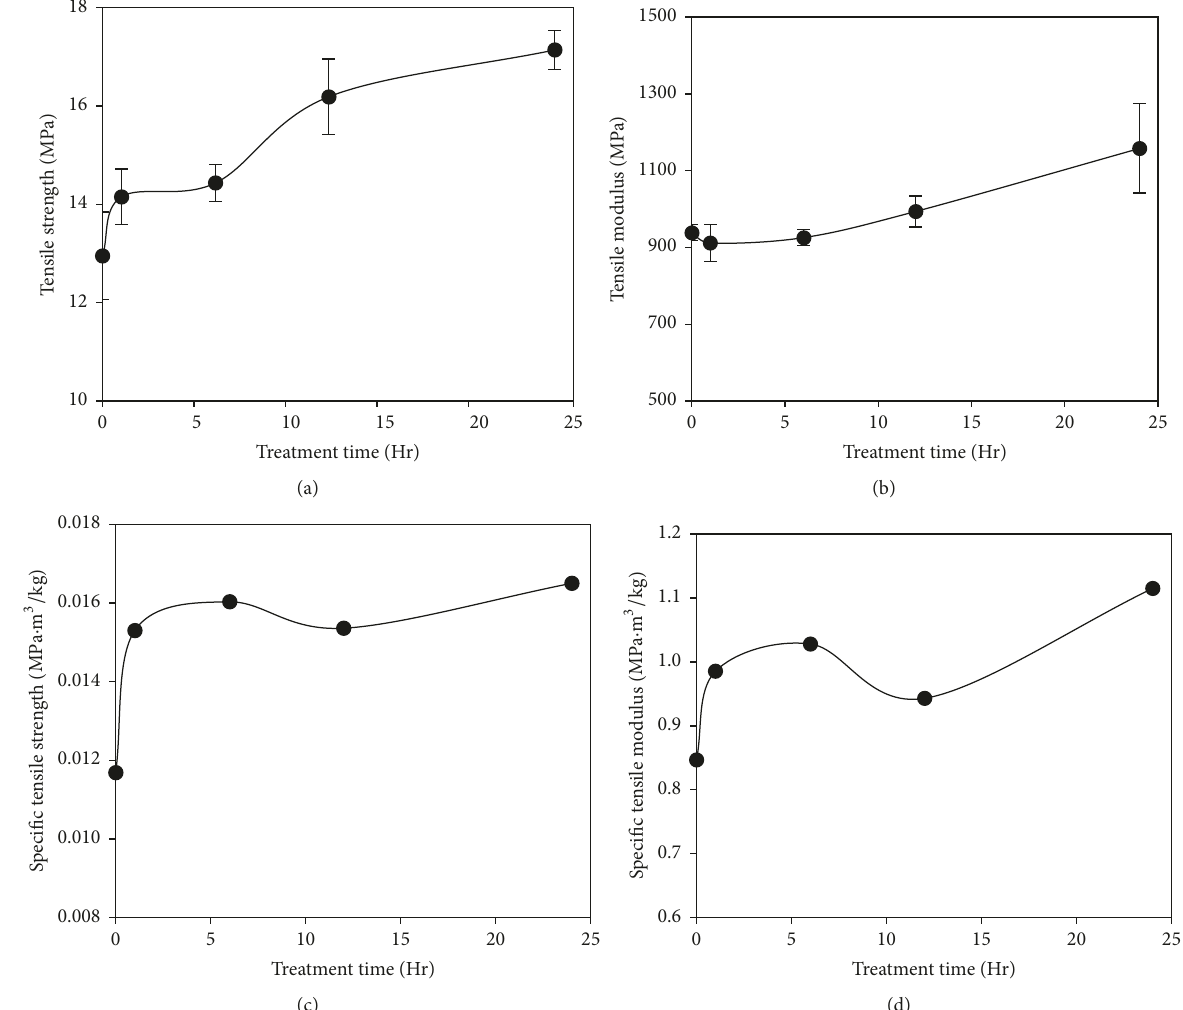
Figure 6: Effect of treatment time on (a) tensile strength, (b) tensile modulus, (c) specific tensile strength, and (d) specific tensile modulus of composite type